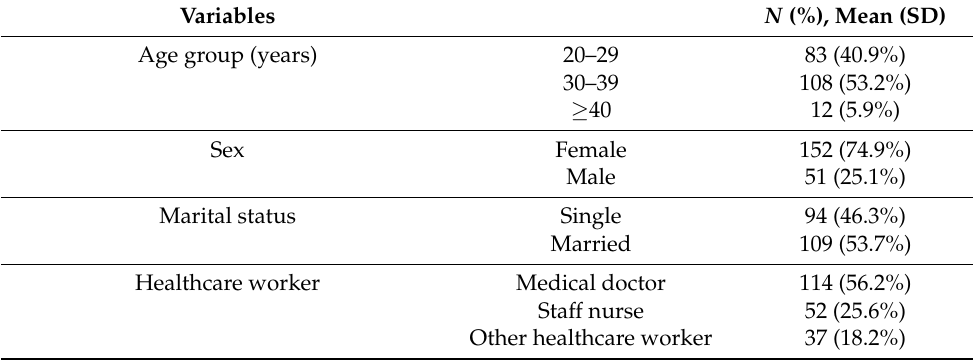
Table 2. The respondents’ background information ( n =